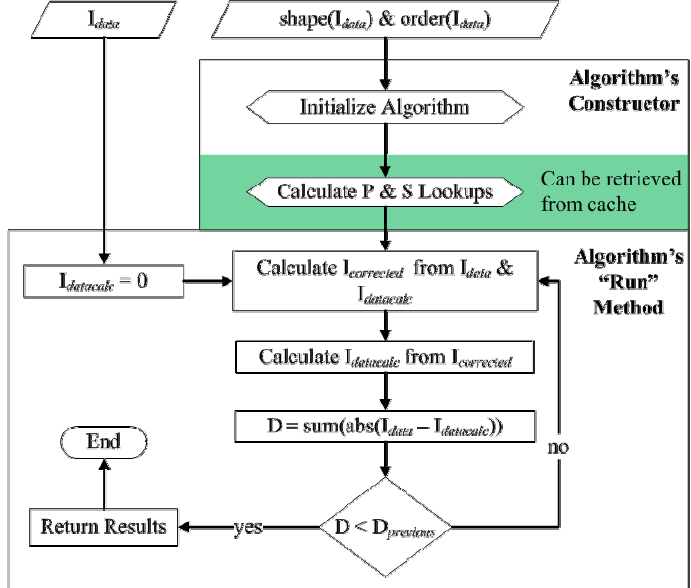
Figure 1. Procedural diagram of the isotopic natural abundance correction